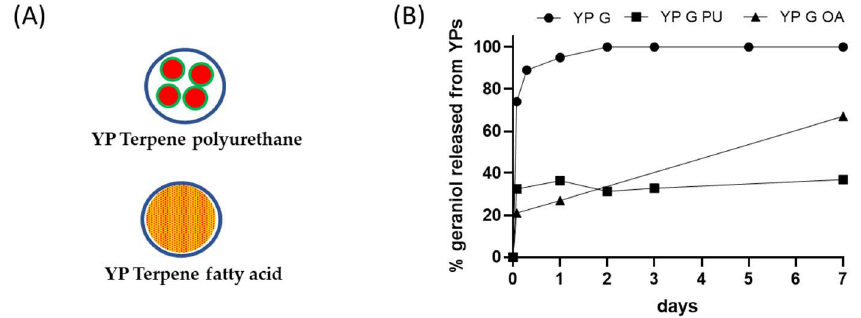
Figure 3. ( A ) Schematics of YP–terpene formulations prepared by encapsulation of terpene in